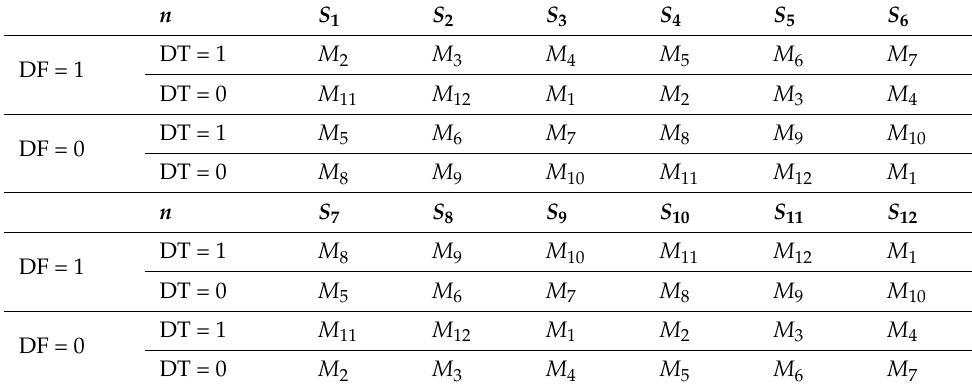
Table 3. Harmonic suppression switch table.